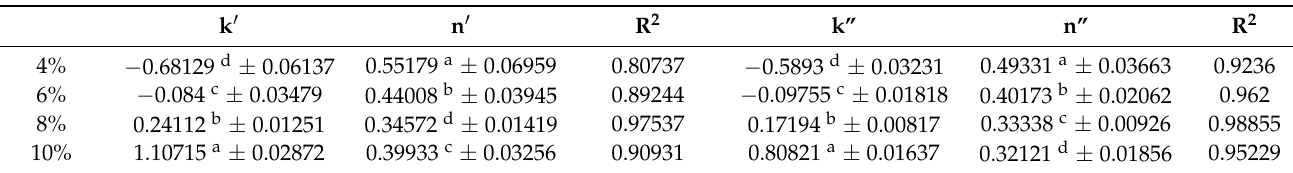
Figure 4. Rheological behaviors of LSEP solutions at 25 °C: Shear-rate-dependent viscosity ( a ) and shear stress ( b ), elastic modulus (G’) ( c ), and viscous modulus (G”) ( d ) as functions of angular frequency ( ω ). Table 2. Parameters of power-law functions describing elastic modulus (G (cid:48) ) and viscous modulus (G”) of the LSEP solutions with different concentrations (4%, 6%, 8%, and